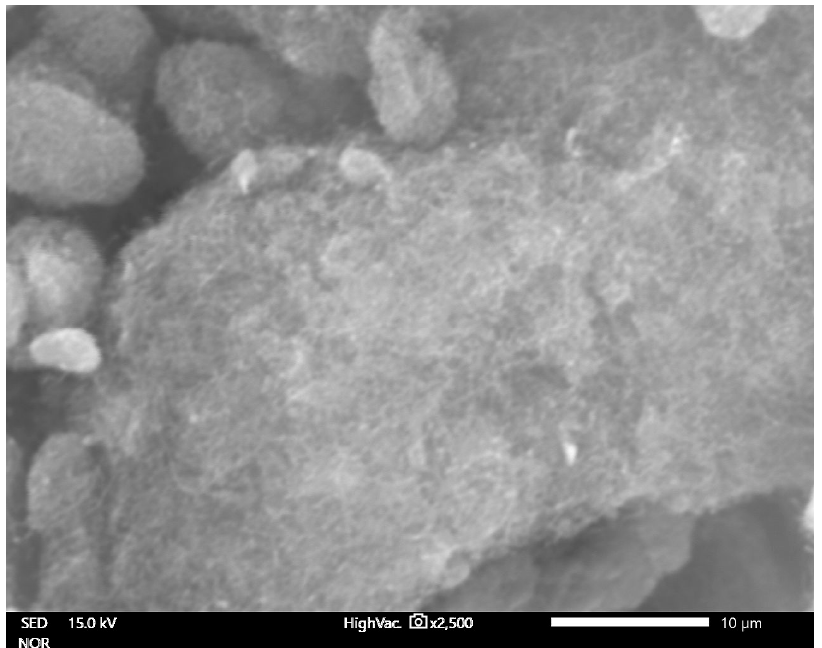
Figure 2. SEM image of ferromagnetic multi-walled carbon nanotubes (MWCNTs)—sample no. 2 (high flow velocity).